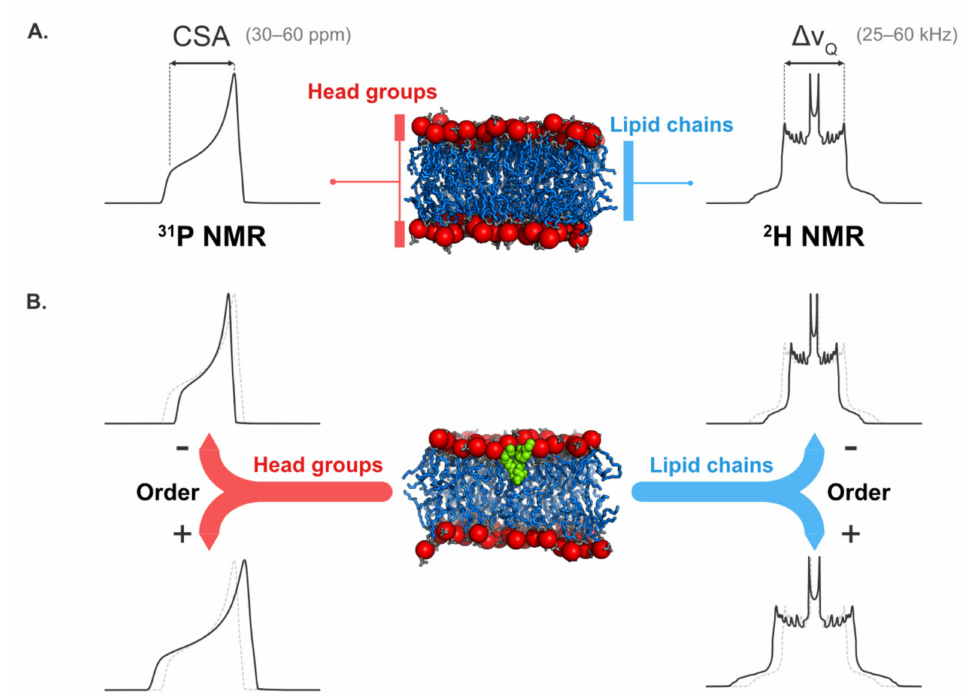
Figure 2. Information on membrane dynamics obtained using solid-state NMR spectroscopy. (Panel A ) showstypical 31 PNMRand 2 HNMRspectraforamembrane.